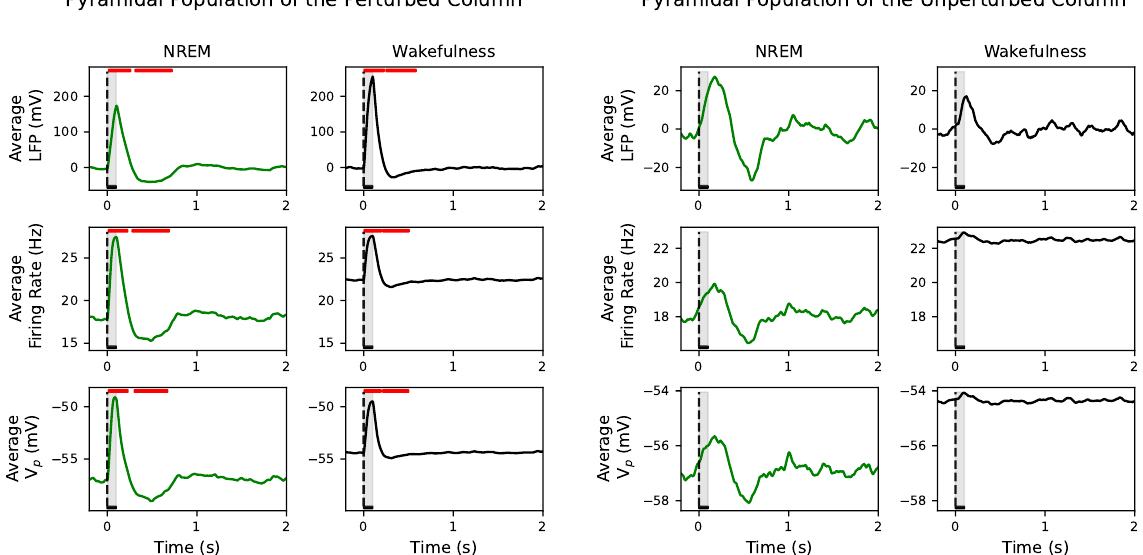
Figure 4. Evoked responses in the two-cortical-column model where β = 1 and ¯ g AMPA = 2. ( A ) Average LFP, firing rate and V p across 500 simulations for NREM sleep (left column) and wakefulness (right column) in the perturbed pyramidal population. Red horizontal bars show the location and length of significant t-cluster statistics when comparing the poststimulus versus the prestimulus intervals. In all signals, as in Figure 3A, responses to the external stimulus consist of one positive and one negative significant deflection. The positive ( p < 0.0007) and negative ( p < 0.001) deflections are significant in NREM and wakefulness. Note that the coupling between the two cortical columns does not change the significance of positive and negative deflections in the evoked responses. ( B ) Results are as in panel ( A ) but for the case of the unperturbed pyramidal population. The evoked responses do not show significant deflections during NREM sleep and wakefulness in the LFP signal, neither in the firing rate nor in V p , where the increase in activity is not significantly higher than the spontaneous activity. In all cases, the dashed vertical line, aligned at zero, indicates stimulus ξ onset. Stimulus duration is represented by a black horizontal line and light gray